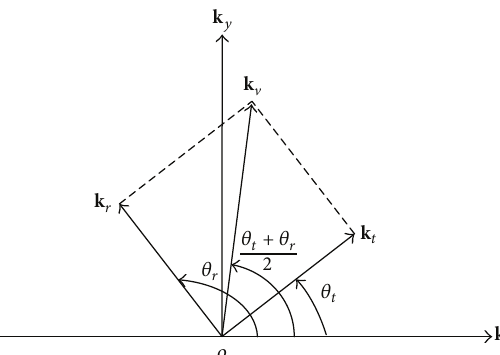
Figure 2: The relationship between the virtual element wavenum- ber, the transmitter wavenumber, and the receive